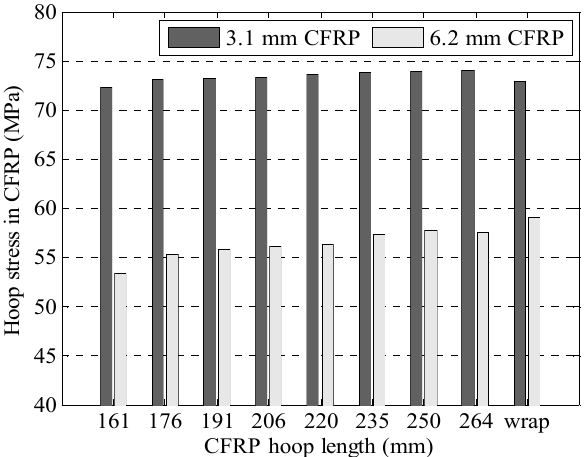
Figure 5. Maximum hoop stress in the pipe wall for different CFRP sizes.